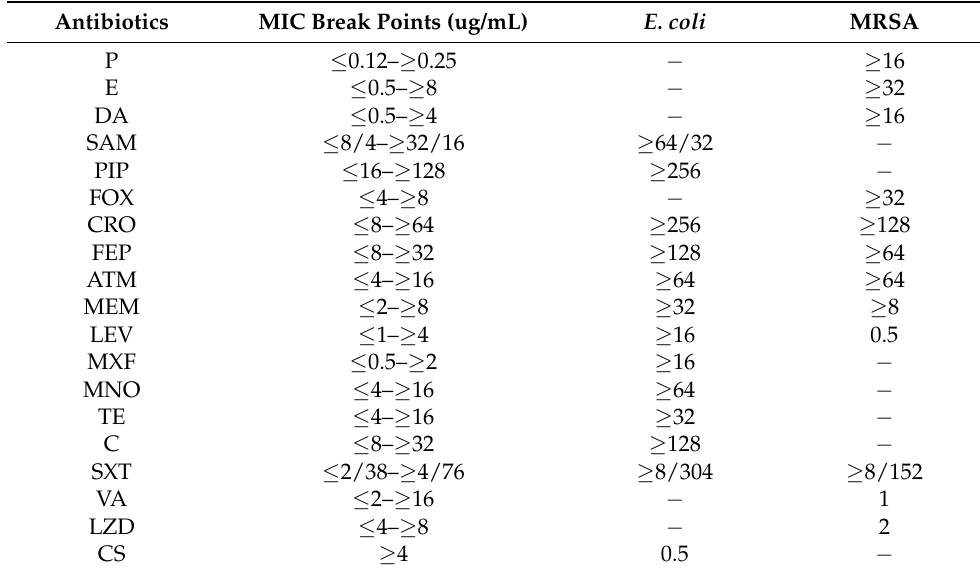
Table 9. MIC ( µ g/mL) of antibiotics against XDR